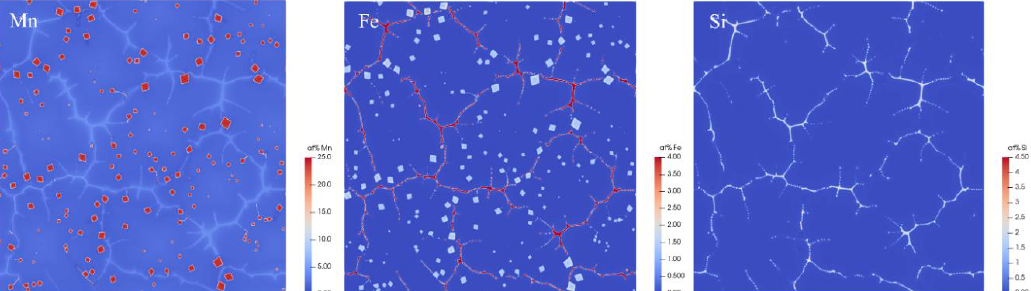
Metals 2020 , 10 , x FOR PEER REVIEW Figure 6. Simulated elemental distributions. Figure 6. Simulated elemental distributions. Table 3. Phase-field simulation parameters.